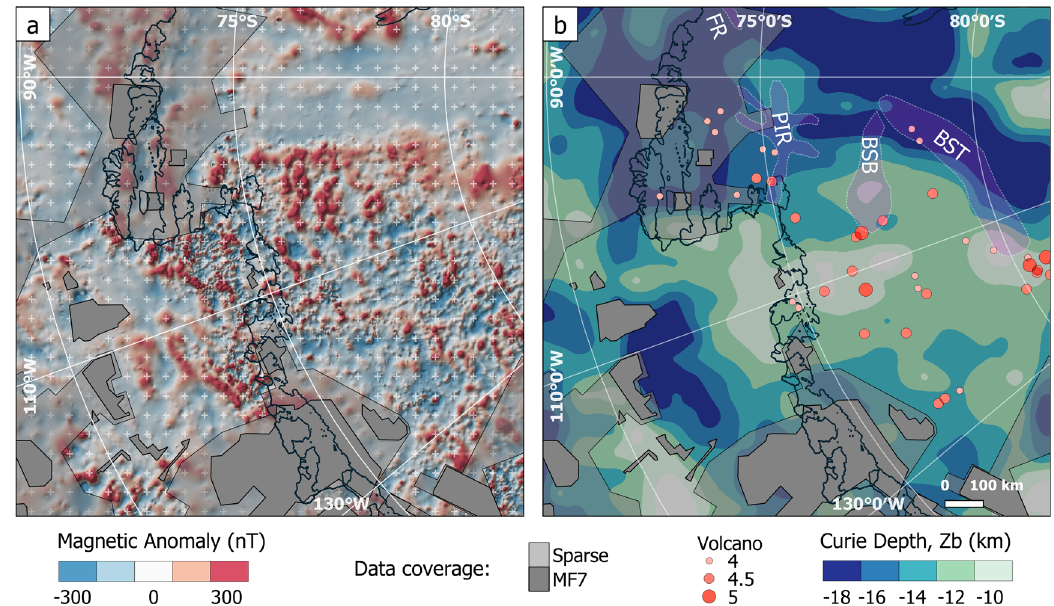
Fig. 2 New magnetic anomaly grid and Curie-depth estimates in the Amundsen Sea sector of West Antarctica. a Magnetic anomaly grid with areas with of low magnetic data coverage indicated in light gray and areas, where data gaps have been substituted with MF7 satellite magnetic data (https:// www.geomag.us/models/MF7.html) shown in dark gray. Small white crosses show locations of the 200 × 200 km window centers for the spectral analysis. b Curie-depth distribution and volcanic centers with a con fi dence factor of 4 or higher 22 . BSB Byrd subglacial basin, BST Bentley subglacial trench, FR Ferrigno rift, PIR Pine Island